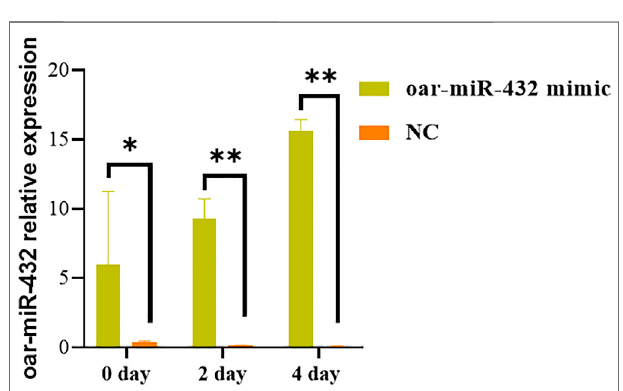
FIGURE 2 | Relative expression levels of oar-miR-432 when oar-miR- 432 mimic and NC were transfected into sheep preadipocytes.